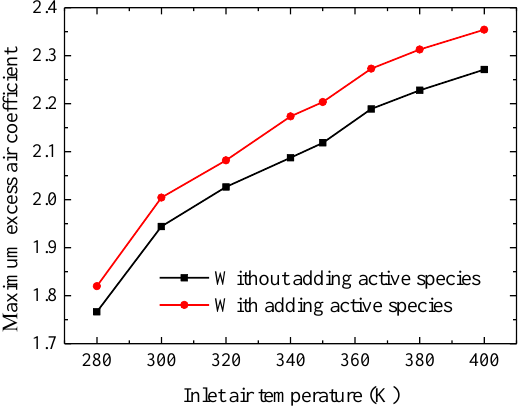
Figure 10. The changing of the combustor ( a ) average temperature and ( b ) chemical reaction rate with time in Cases A–E.